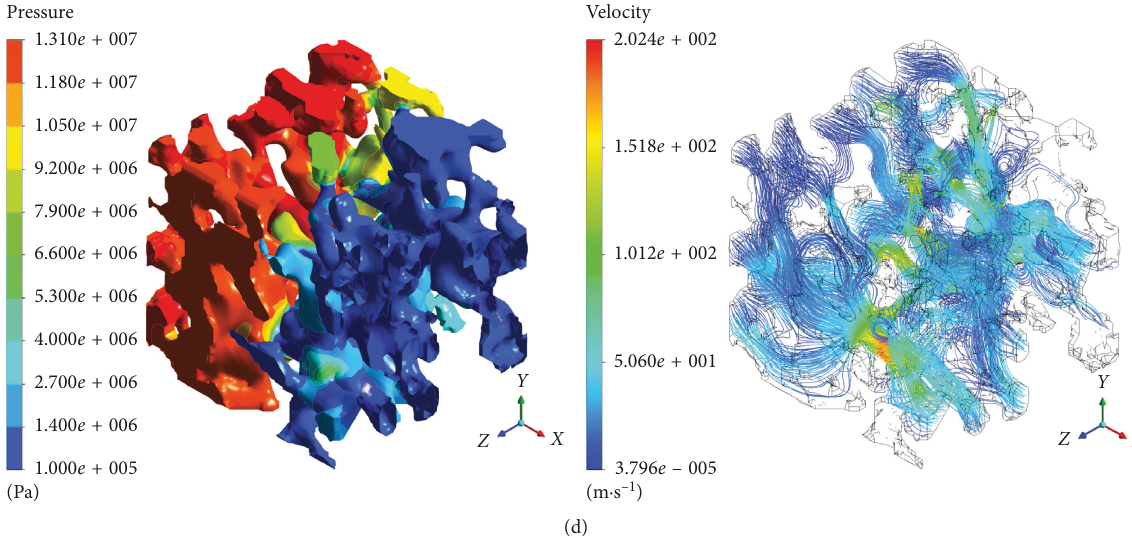
Figure 21: Distribution of pressure and velocity fields in four different models under a high inlet pressure of 13.1 MPa. (a) Results in model P 1 . (b) Results in model P 2 . (c) Results in model P 3 . (d) Results in model P 4